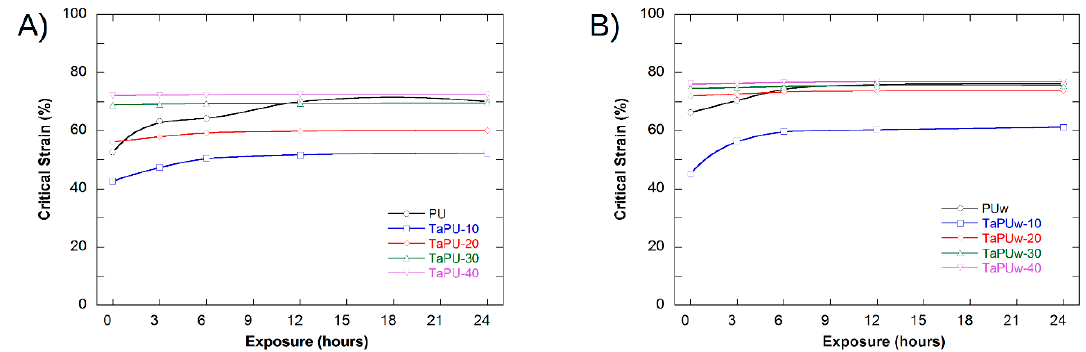
Figure 11. Variation of the critical strain as a function of UV exposure time: ( A ) without added water; ( B ) with added water. (The solid lines are shown to guide the eyes.)